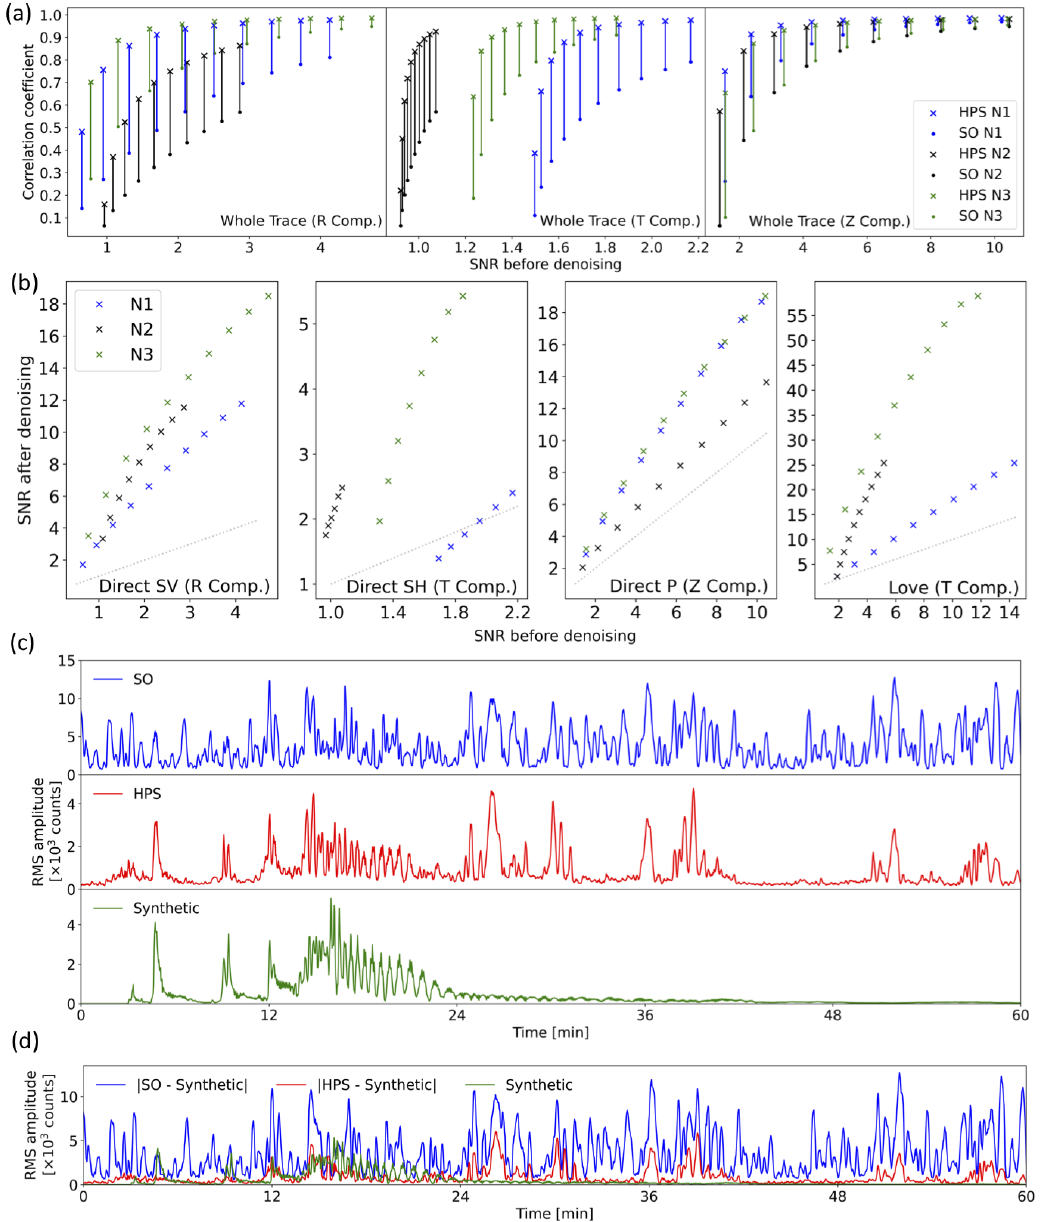
Figure 4. Comparison of the synthetic SO and HPS signals (both are low-pass-filtered at 1Hz). (a) Correlation coefficients (for the whole trace) for different SNRs and three realistic noise realizations for Z, R, and T components (component is abbreviated as Comp.). (b) Improve- ment of SNR for direct body-wave phases and the Love wave. The gray dotted lines in (b) mark the line with gradient 1 (no improvement of SNR). (c) Comparison of the root mean square (rms) amplitude of one example of the SO, HPS, and synthetic earthquake signals. This signal is the same example shown in Fig. 3 (R component, SNR = 1.5 before denoising). (d) The rms of the original noise (blue trace: | SO – synthetic | ) and the remaining noise after denoising (red trace: | HPS – synthetic | ) compared to the synthetic earthquake